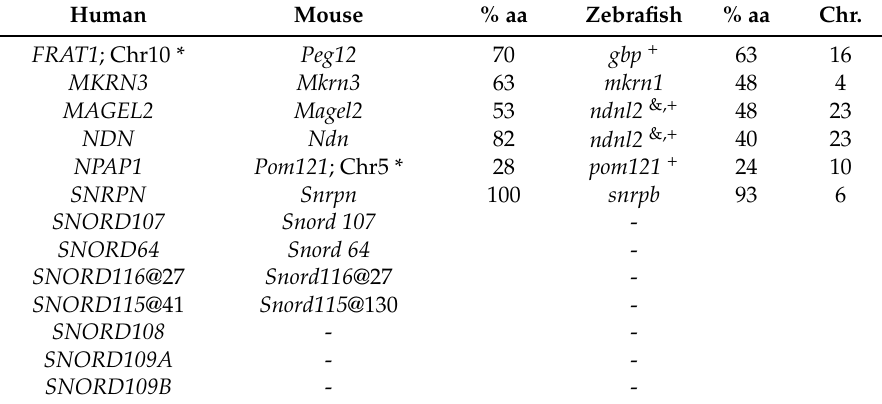
Table 2. Mouse and zebrafish PWS-related